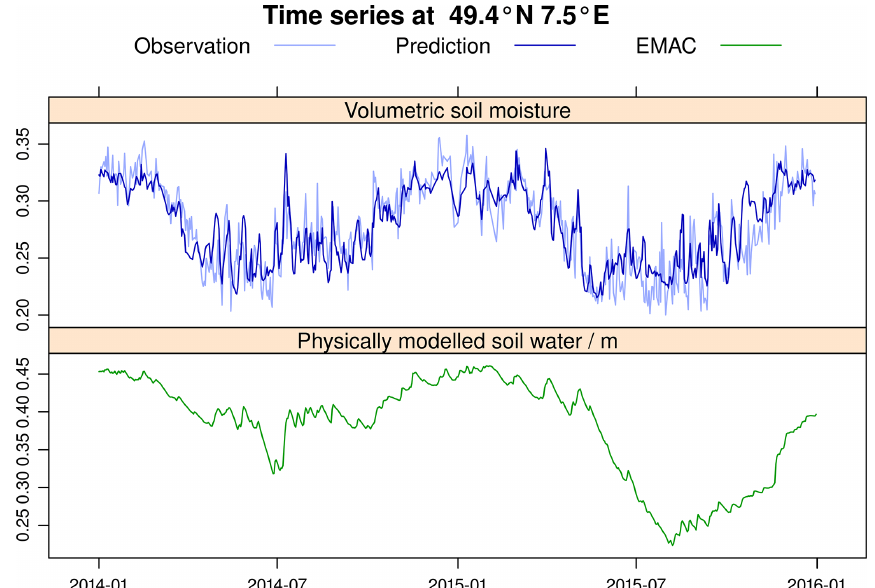
Figure 5. Time series of the observed and predicted daily volumetric soil moisture values and the EMAC soil water in the grid cell centred at 49.4 ◦ N, 7.5 ◦ E in